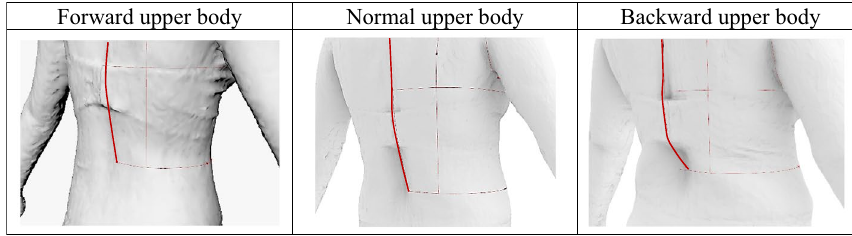
Fig. 9 The path to detect the back waist point